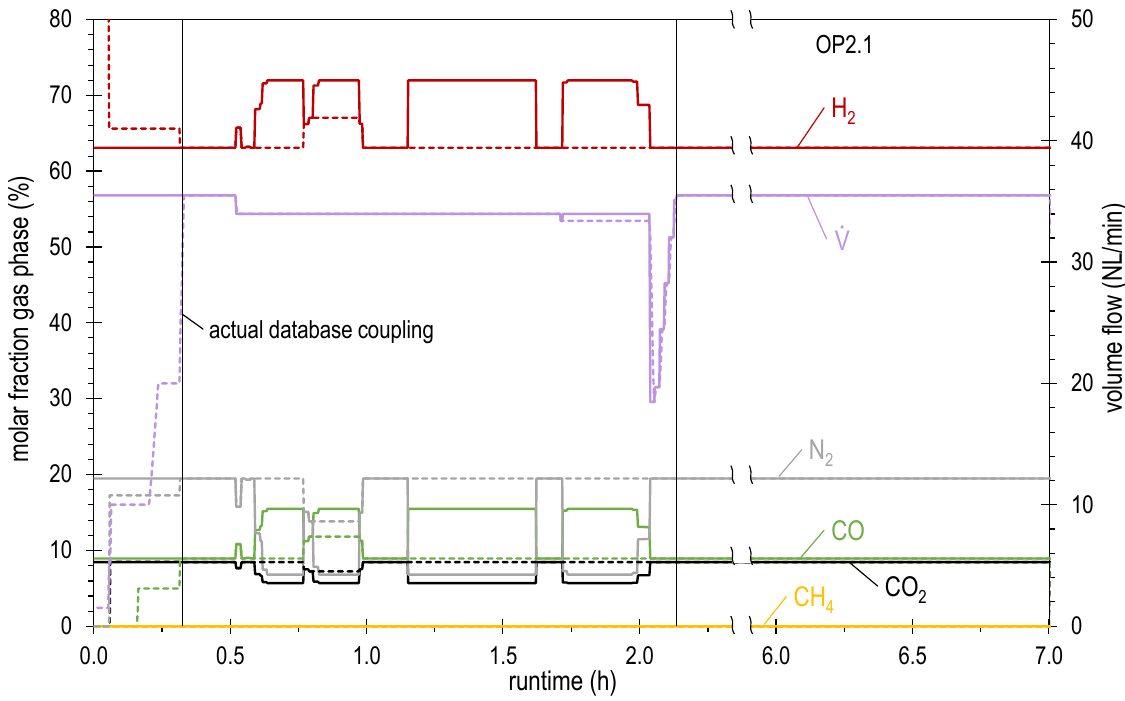
Figure 18. SC2. Handover values received from DC (solid lines) and set values of the MFC (dashed lines) for FAU_CH4_TR.